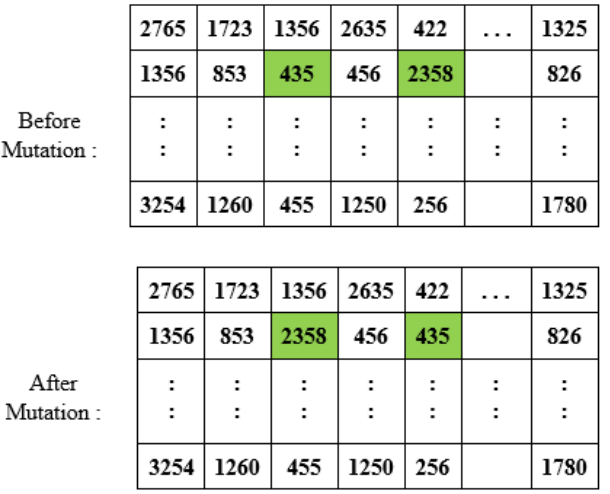
Fig. 13. Value exchange local search operator for brit value